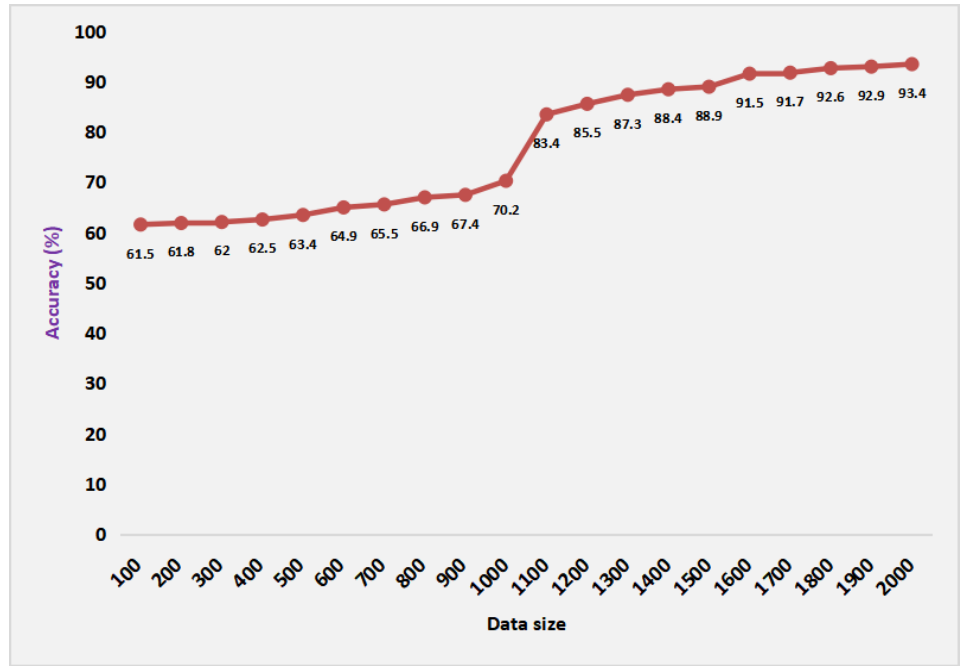
Figure 9. Sensitivity analysis with respect to the data size using CBECS dataset samples.